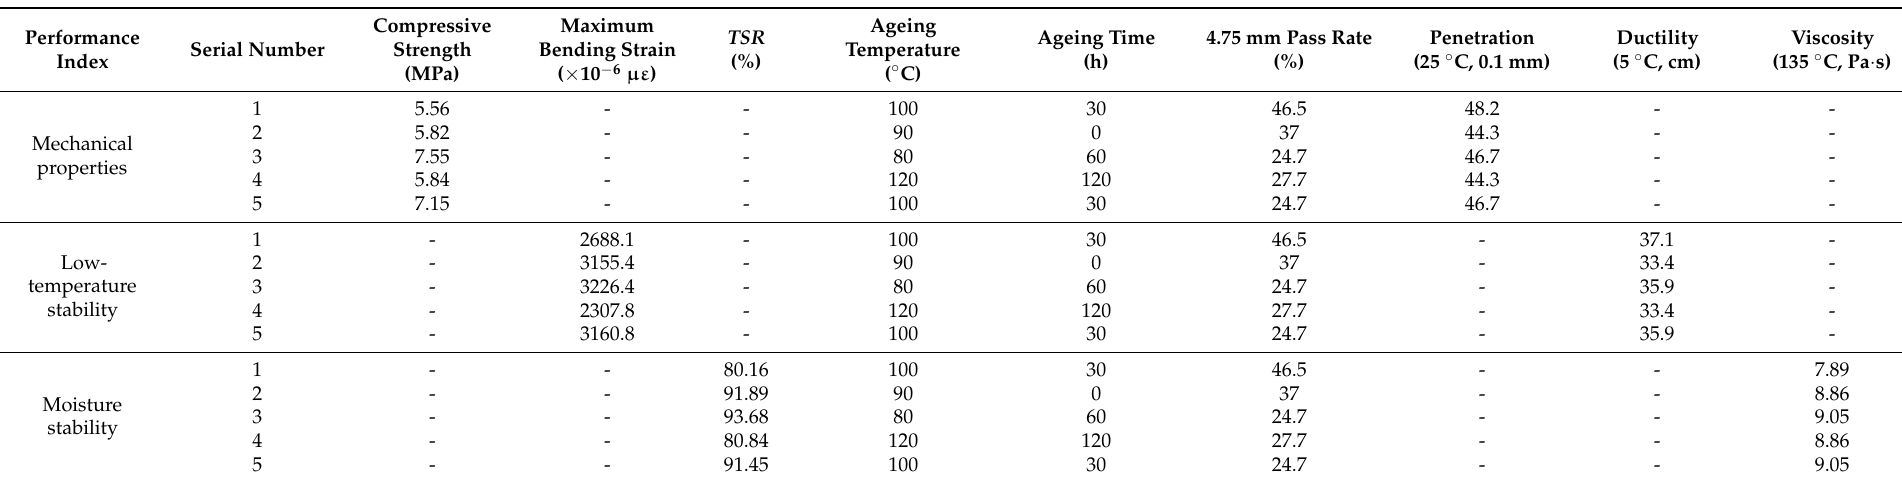
Table 9. Evaluation indexes and influence parameters of ageing durability of fiber asphalt mixture.